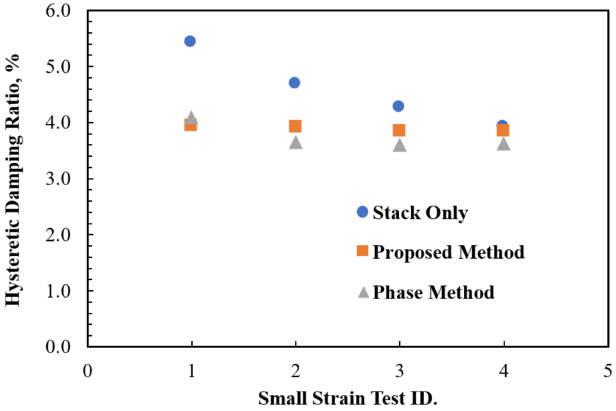
Figure 9. Comparisons of λ min from the three methods.